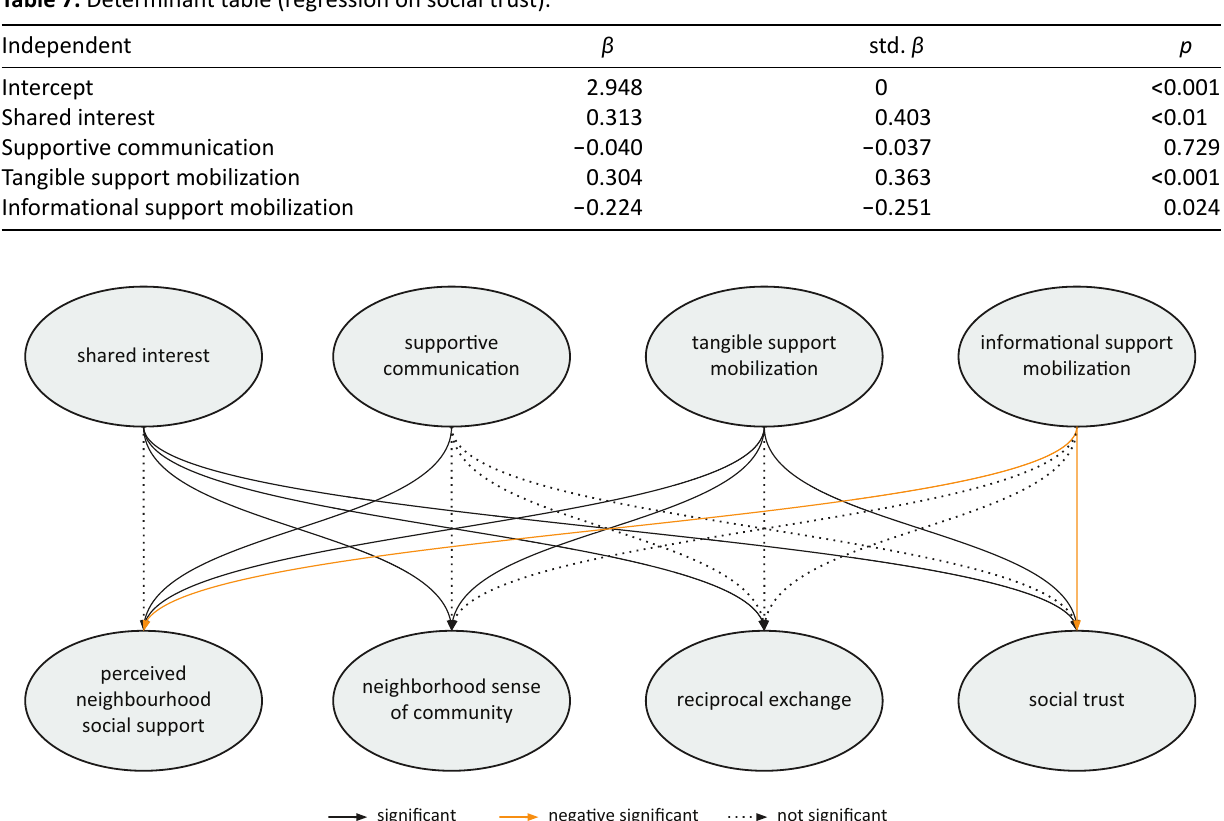
Figure 2. Relationships between ONN communication practices and neighborhood social